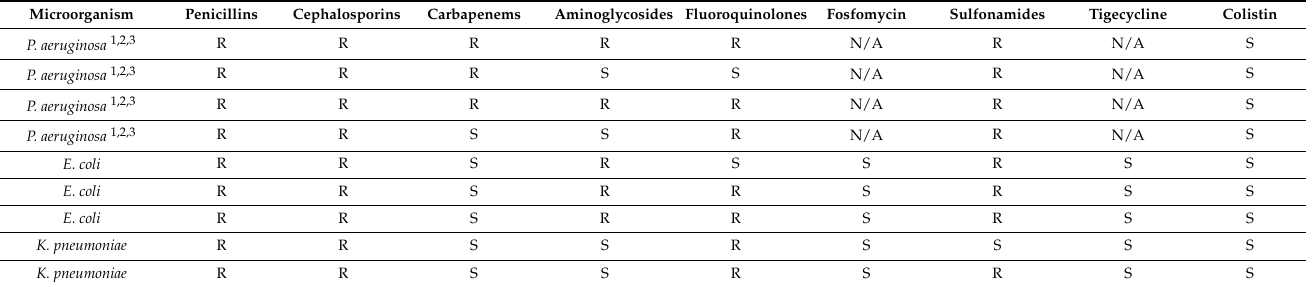
Table 2. Susceptibility to antibiotic classes for the micro-organisms classified as multidrug resistant.